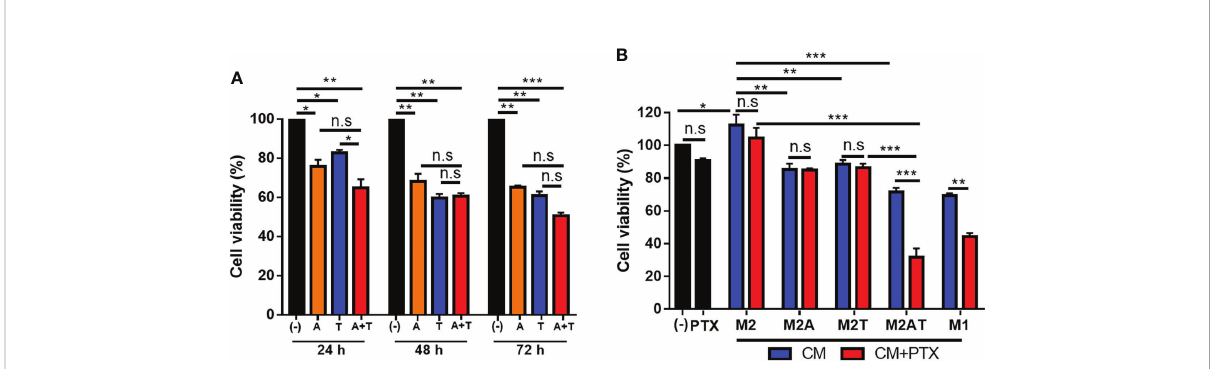
FIGURE 2 Conditioned medium (CM) of M2-type macrophages treated with the combination of 5-aza-dC and TSA inhibits tumor cell survival and sensitizes tumor cells to chemotherapy. (A) Cell viability of 4T1 tumor cells after treatment with 50 nM 5-aza-dC (referred as A) and 25 nM TSA (referred as T), alone or in combination (A+T), for 24 – 72 (h) (B) Cell viability of 4T1 tumor cells after incubation with the CM of M2- macrophages (M2) treated with 5-aza-dC (M2A) and TSA (M2T), alone or in combination (M2AT), in the absence (blue bars) or presence of 1 m M paclitaxel (PTX, red bars), for 24 h. Black bars represent untreated (-) and PTX-treated tumor cells in the absence of CM. The CM of M1- macrophages (M1) was used as a control. Data represent the mean ± SD of three separate experiments performed in triplicates. *, P <0.05; ***, P <0.001; n.s., not signi fi cant, as assessed using one-way ANOVA followed by Tukey ’ s multiple comparison post-hoc test (A) or two-way ANOVA followed by Bonferroni multiple comparisons post-hoc test (B)